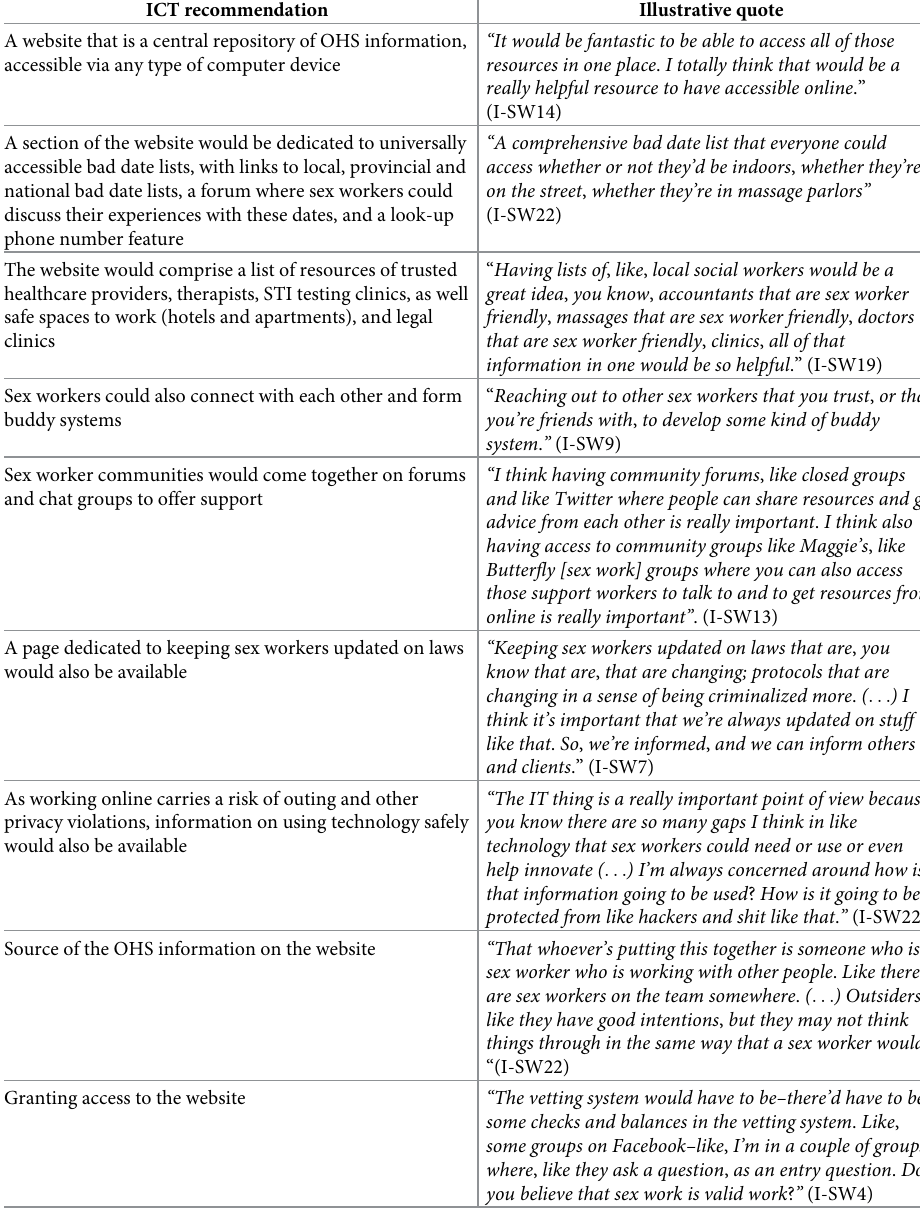
Table 3. Participant recommendations for ICTs for OHS risk